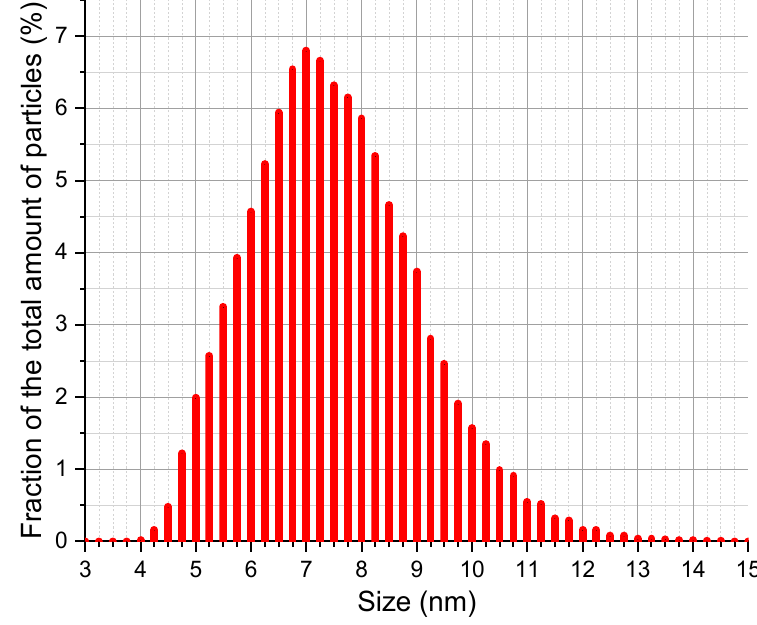
Figure 1. Size distribution of fullerene C 60 in 2% solution of TWEEN 80 in water.